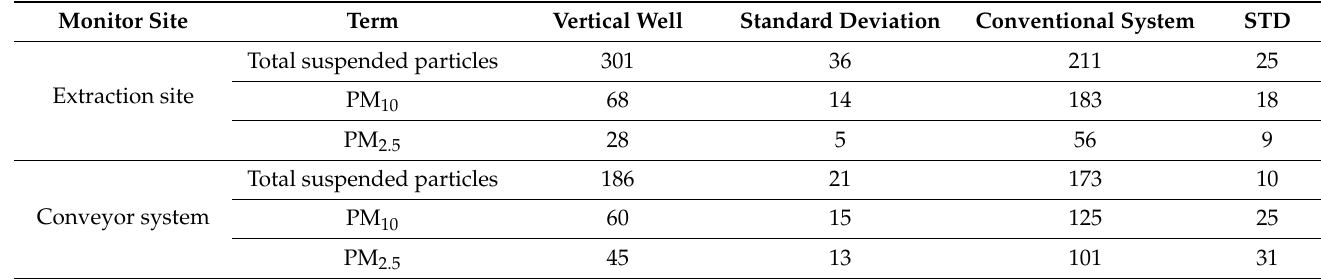
Table 5. Relation between transport system and dust concentration